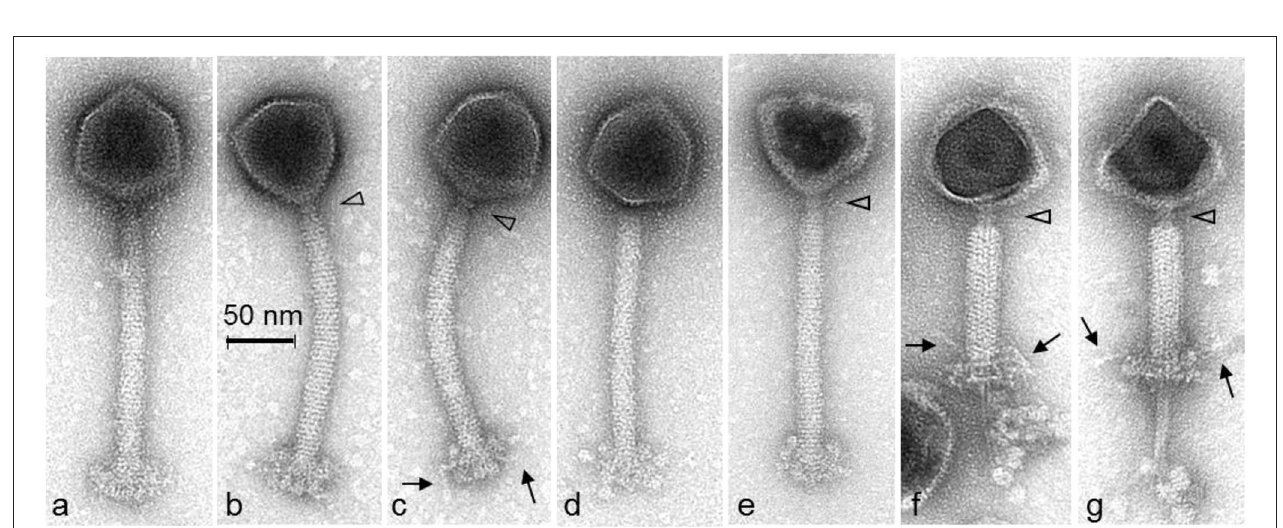
FIGURE 1 | Linear view of the annotated draft genome of phage P61 visualized using EasyFig 2.2.4. The area 10,406–13,717 bp is marked with a box to indicate where the terminal repeat region of phage A511 maps to the draft genome of phage P61.